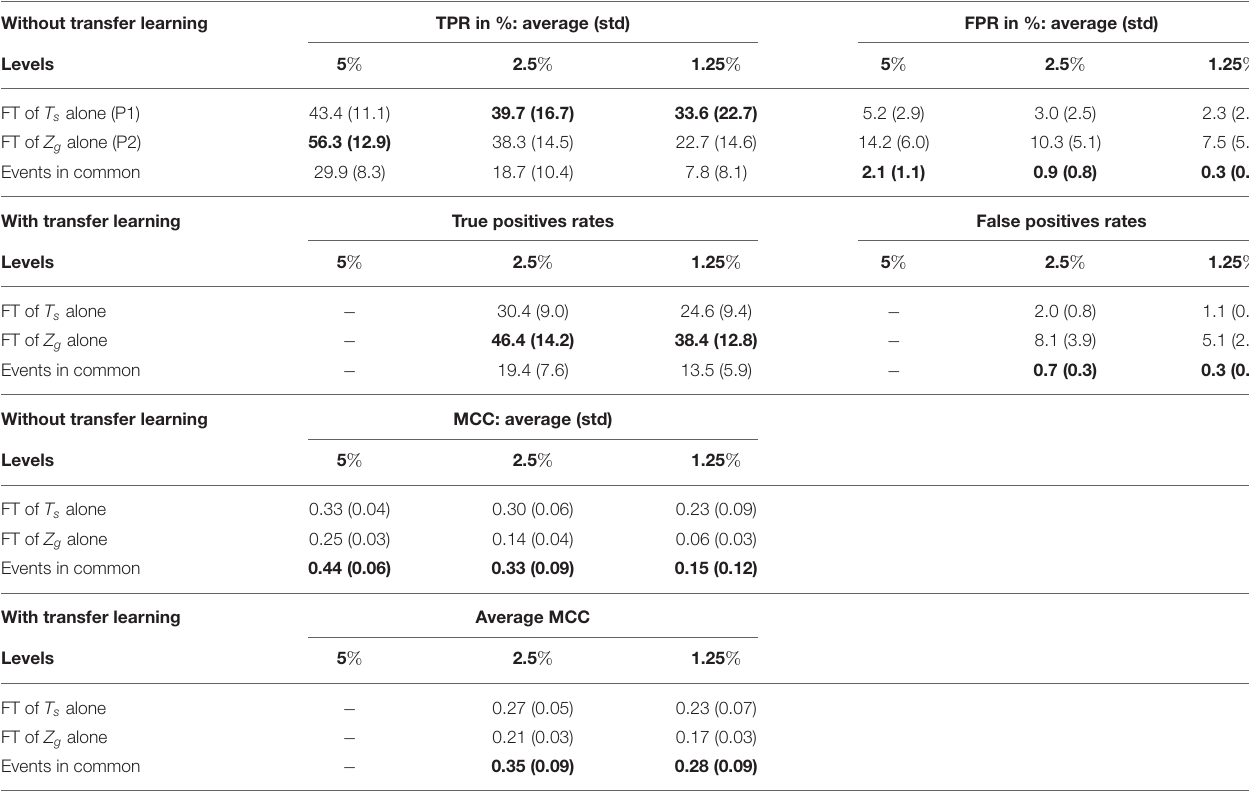
TABLE 1 | Compared performance for heatwave occurrence prediction from surface temperature vs. geopotential height. Without transfer